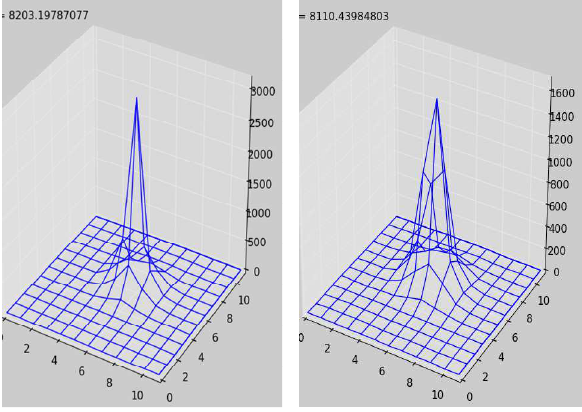
Figure 3 : example of PA MTF measured on stars for different defocusing adjustments